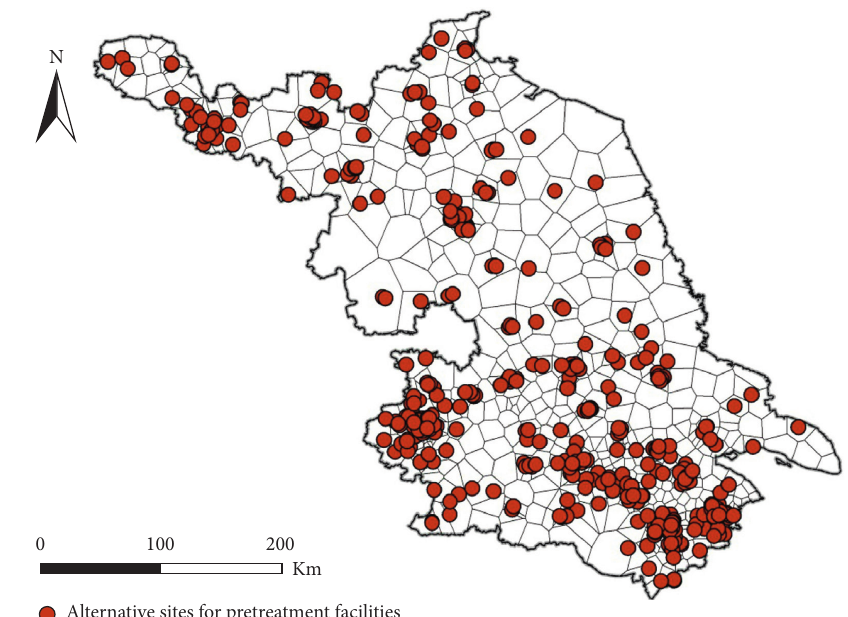
Figure 6: Alternative pretreatment facilities in Jiangsu Province. Table 4: Parameters of the pretreatment